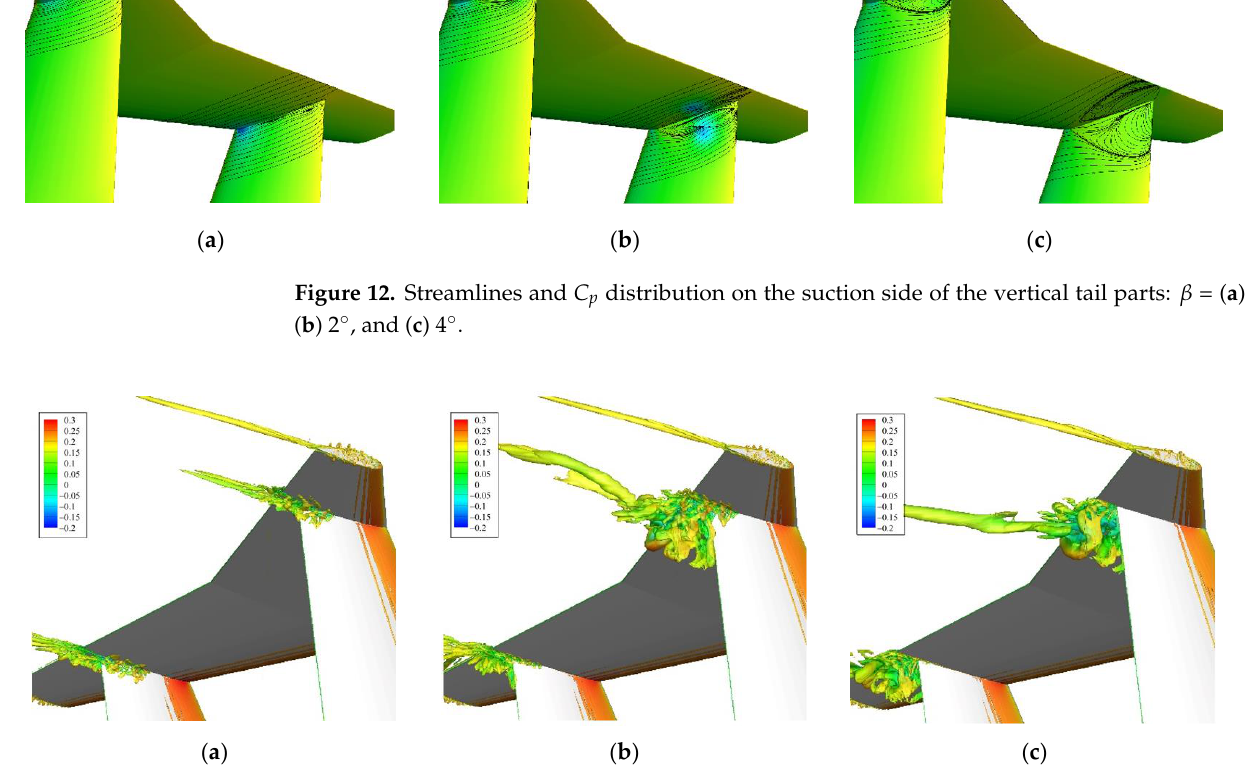
Figure 14. Ω = 0.52 isosurface , looking from the suction side of vertical tail parts: β = ( a ) 0°, ( b ) 2°, and ( c ) 4°. 4. Improved Design of T-Tail Junctions 4.1. Geometry According to the literature [2,13,33], corner separation is mainly related to the BL, and with increasing thickness and energy of the BL, the corner separation becomes smaller or is even suppressed completely. However, because (i) there are no fairing cones in front of the horizontal-vertical tail junctions of the demonstration aircraft, and (ii) the leading